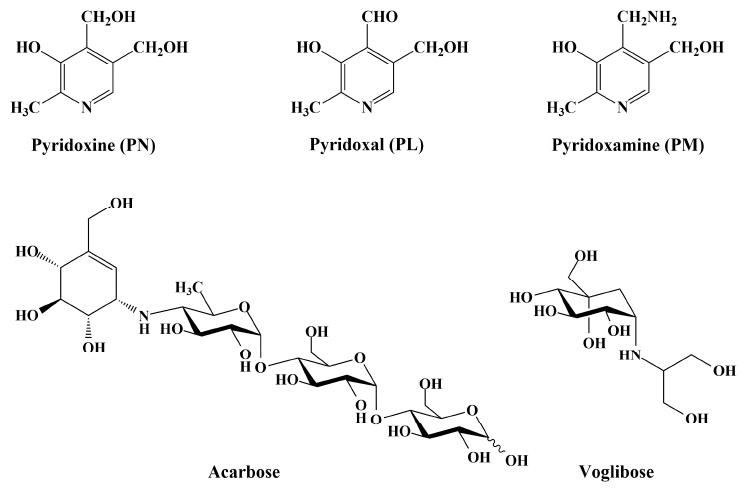
Figure 1. Structure of pyridoxine and its derivatives (pyridoxal and pyridoxamine) and commercial α -glucosidase inhibitors (Acarbose ® and Voglibose ® ).